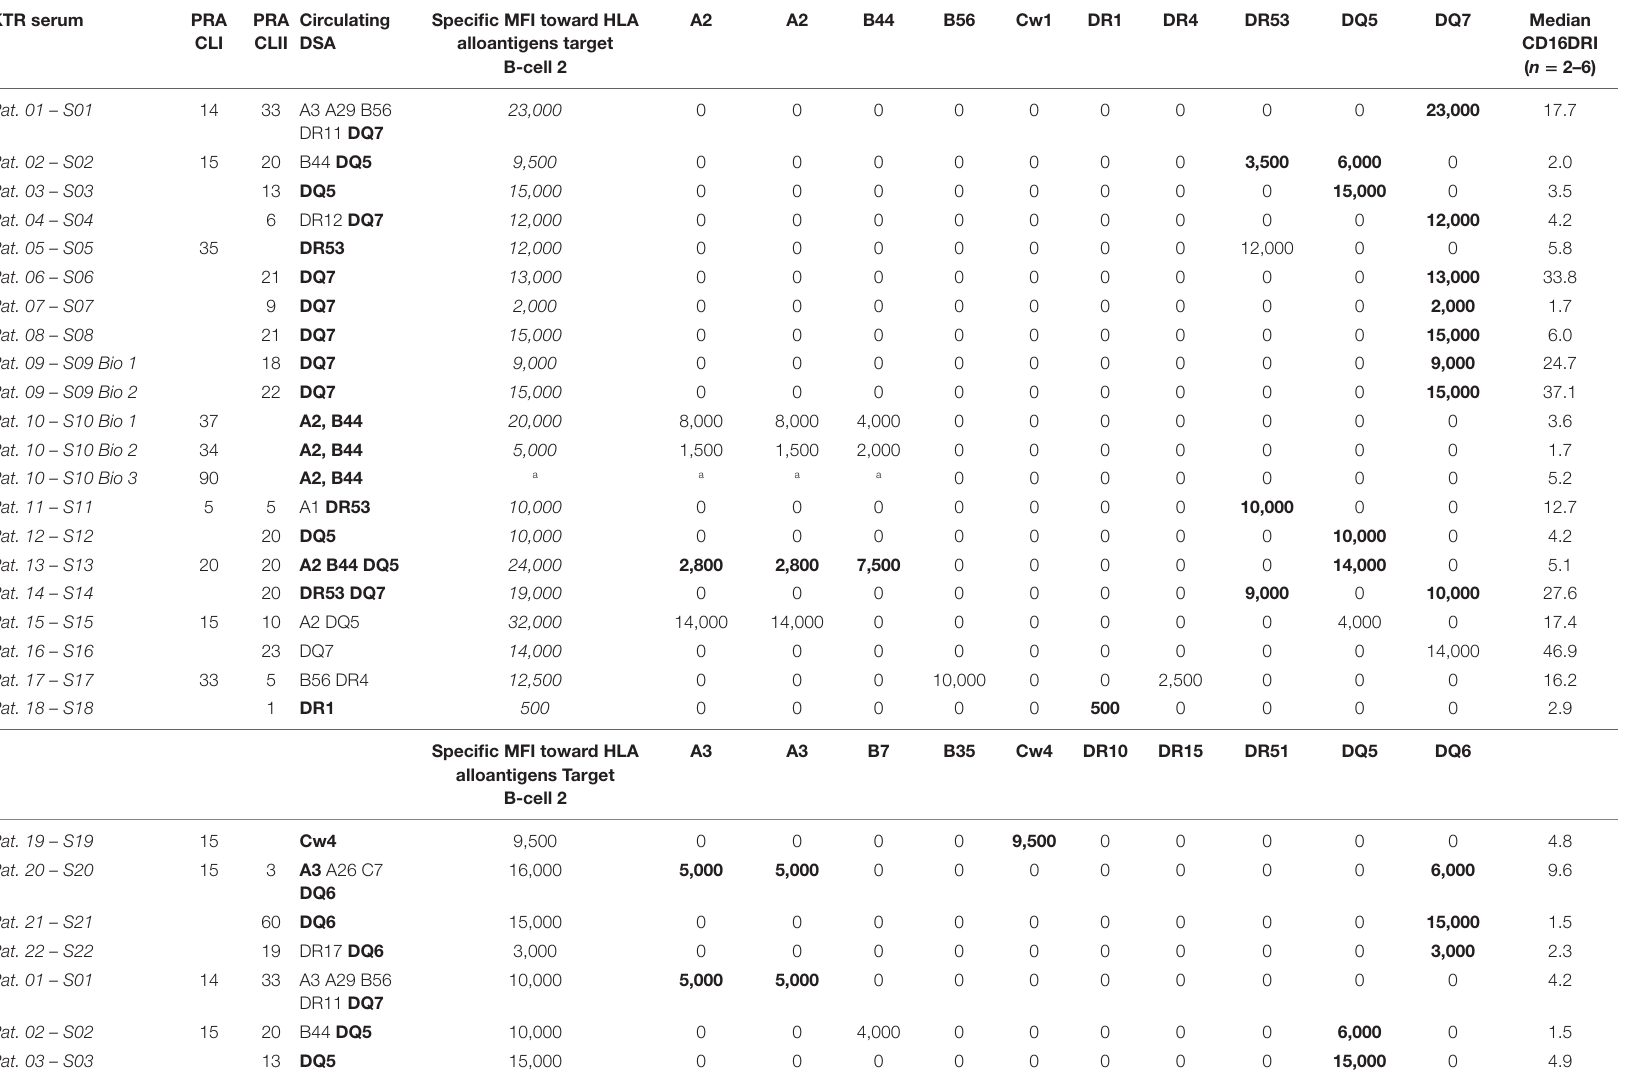
TaBle 4 | Pra and MFi of 25 Dsa + serum samples subjected to evaluation of the cD16Dri score at the time of biopsy. KTr